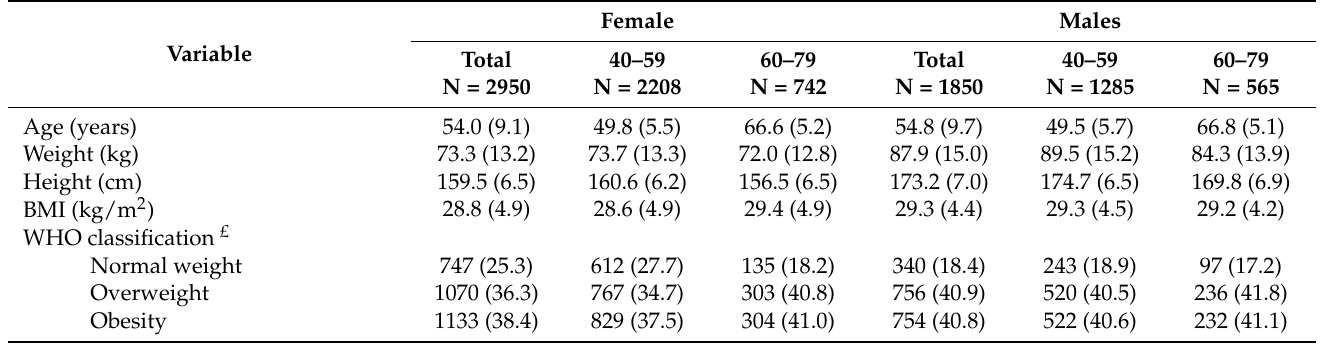
Table 1. Anthropometric and body composition characteristics of the study sample ( n = 4800) Ŧ